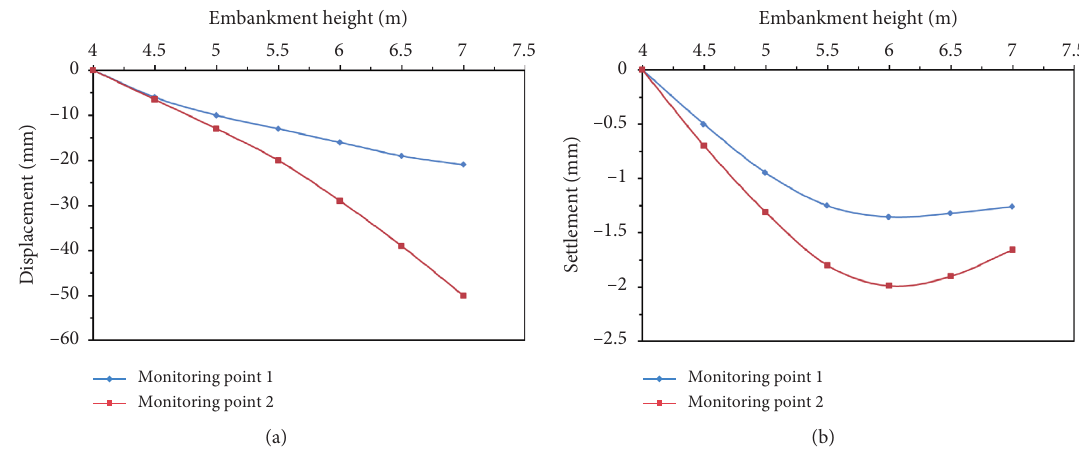
Figure 5: Displacement of the soil body at monitoring points. (a) Horizontal displacement and (b) settlement.